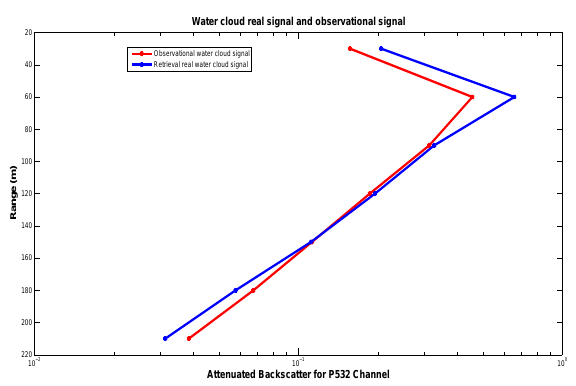
Fig. 3. The retrieved attenuated backscatter signal beneath the water cloud peak return and the observed attenuated backscatter by CALIOP. The red line is the observed (current) water cloud signal and the blue line is the retrieved (corrected or real) cloud signal.